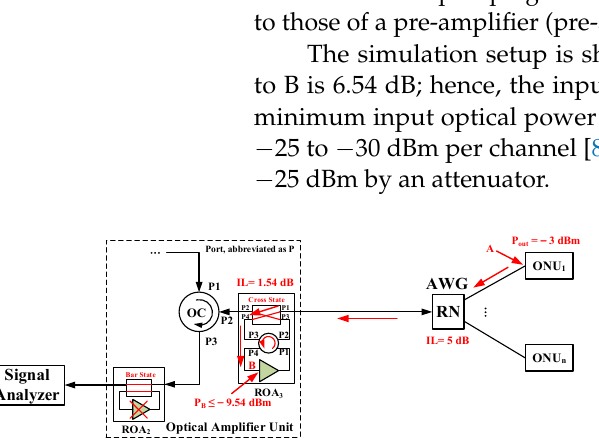
Figure 9. NF vs. EDF length and P out vs. EDF length at various pumping power values.